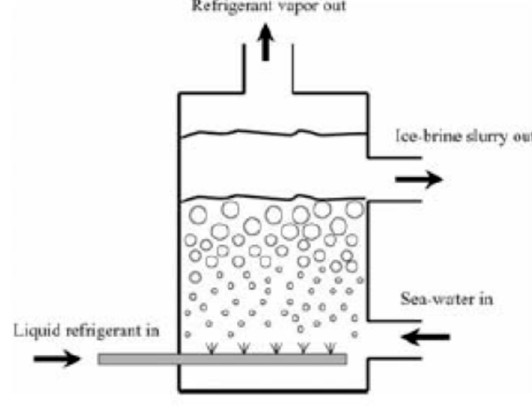
Figure 15. Direct freezing [110].